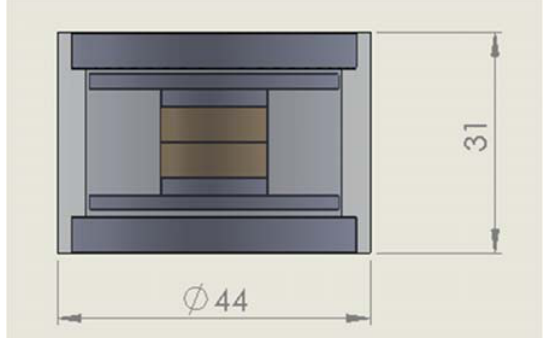
on each end for the smart MR fluid to enter and depart. The dimensions of this valve are shown in Figure